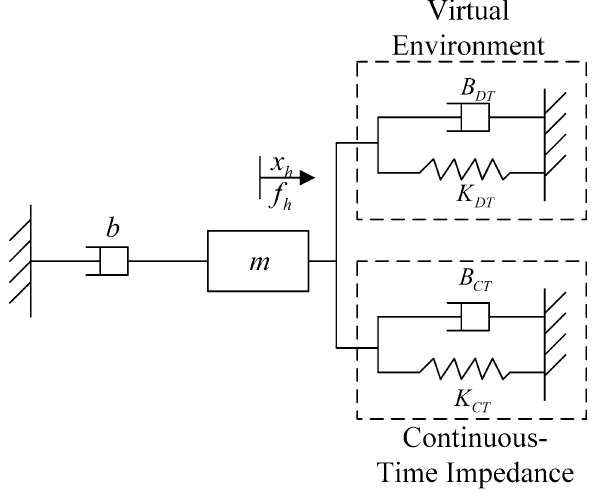
Figure 1. A single-user haptic virtual surgery simulation system with an analogue controller.